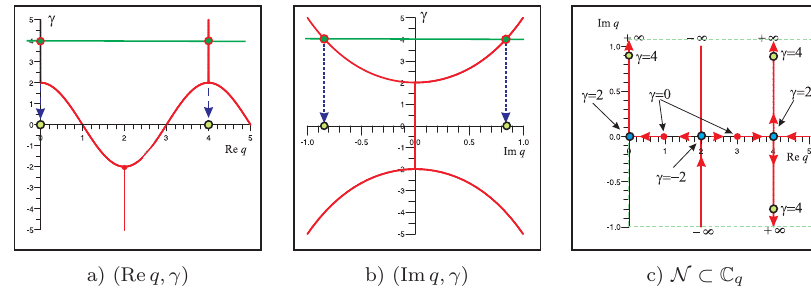
Figure 6. Projections of the complex-real characteristic function γ ( πq ) for ξ = 1 / 2